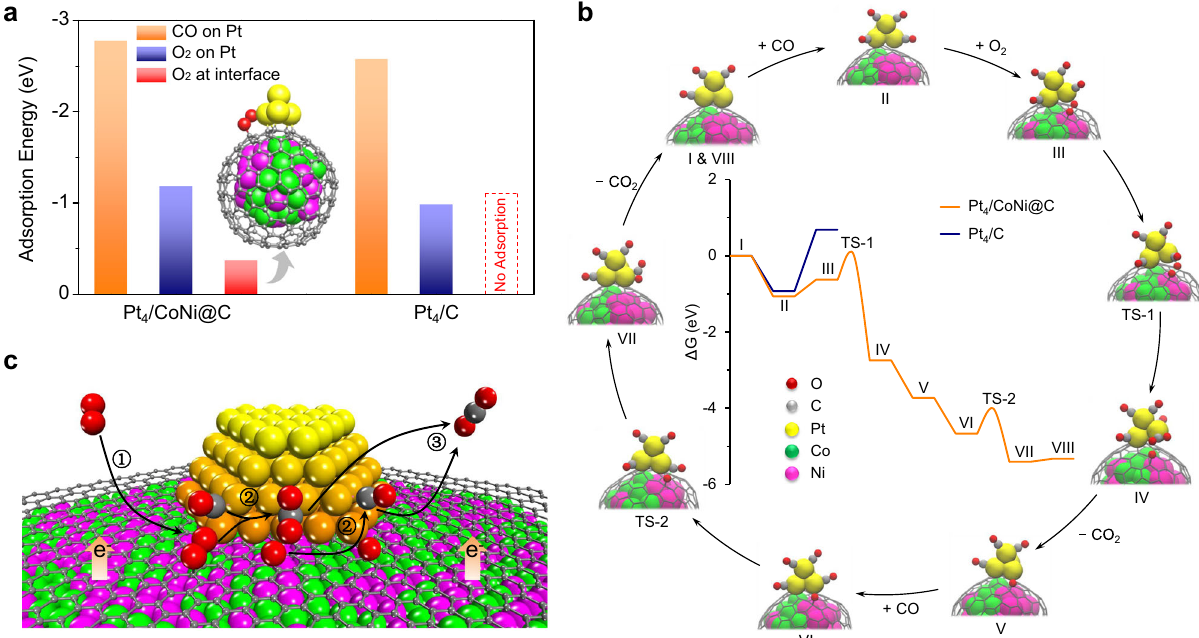
Fig. 3 DFT calculations on the catalytic mechanism of CO oxidation over Pt on graphene encapsulating CoNi alloy. a Adsorption energy of CO and O 2 on Pt 4 /CoNi@C and Pt 4 /C. b CO oxidation energy pro fi les over Pt 4 /CoNi@C (red line) and Pt 4 /C (blue line) and the structures of intermediates for Pt 4 / CoNi@C. “ TS ” represents transition state. c Schematic diagram of electron penetration triggering interface activity of Pt – graphene for CO oxidation at room temperature. The red, grey, yellow, green, and pink balls represent O, C, Pt, Co, and Ni, respectively. (Step 1: O 2 adsorption at the Pt – graphene interface, step 2: surface reaction between CO and O, step 3: CO 2 release from the Pt – graphene